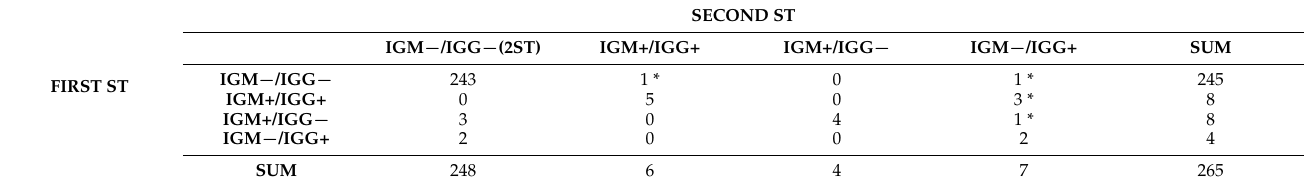
Table 2. First and second serology test (ST) results. * indicates subjects in which the NPS was found positive (one case for